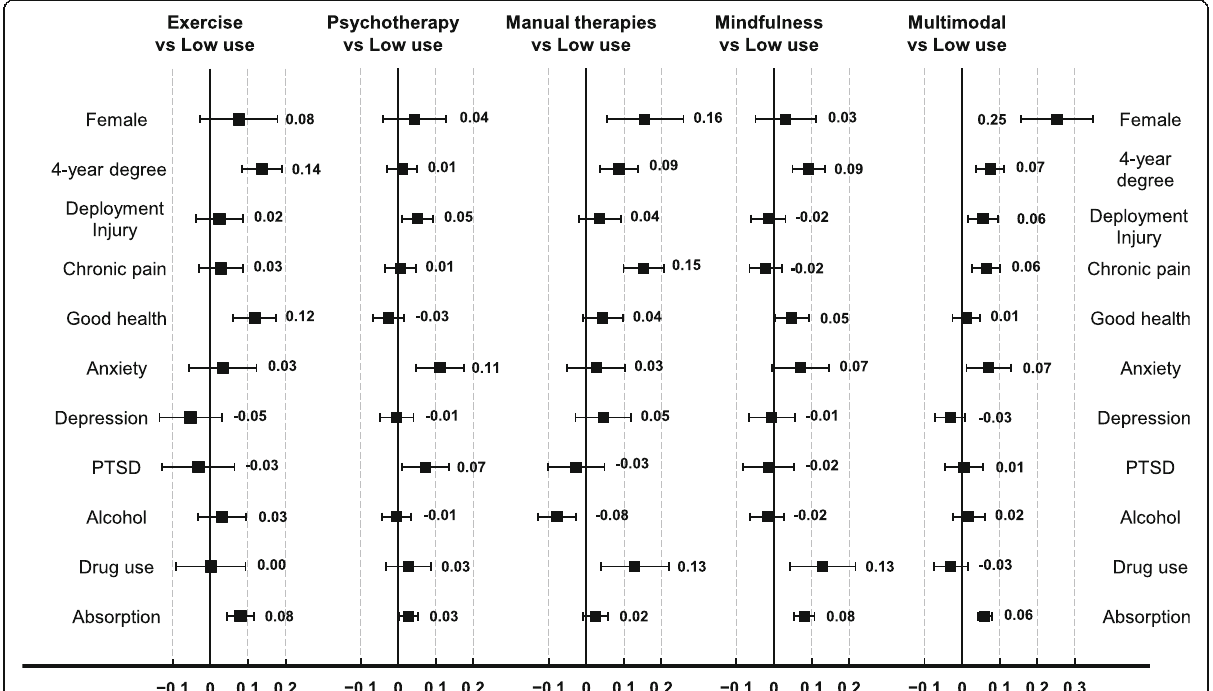
Fig. 1 Prevalence differences of class membership due to covariates; results of multinomial logistic regression from Minnesota National Guard Veterans who participated in the mailed survey conducted from October 2015 to September 2016. Interpreted as the difference in risk (probability) of membership in this latent class between levels of the covariate where a negative value means lower probability of membership in this class compared to probability at the reference level of the covariate; other covariates are standardized to their distribution among all responder. All covariates are dichotomous except for absorption, which is continuous. For absorption, a one-unit change represents a 2-point change on the absorption scale, equivalently a 7-point change on the